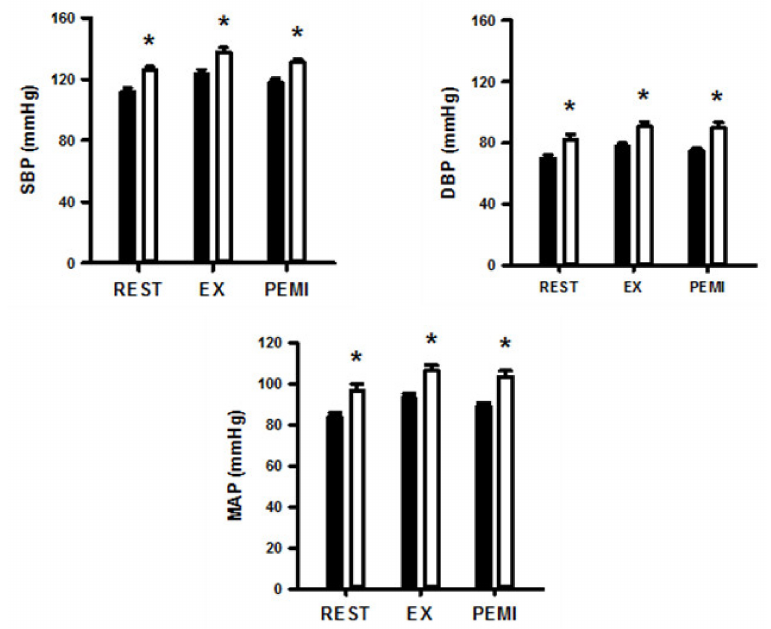
Figure 2. Systolic blood pressure (SBP), diastolic blood pressure (DBP), and mean arterial pressure (MAP) during dynamic exercise and post-exercise muscular ischemia (PEMI) in normal and obese individuals. Black bar, normal; open bar, obese. * p < 0.05, vs. normal